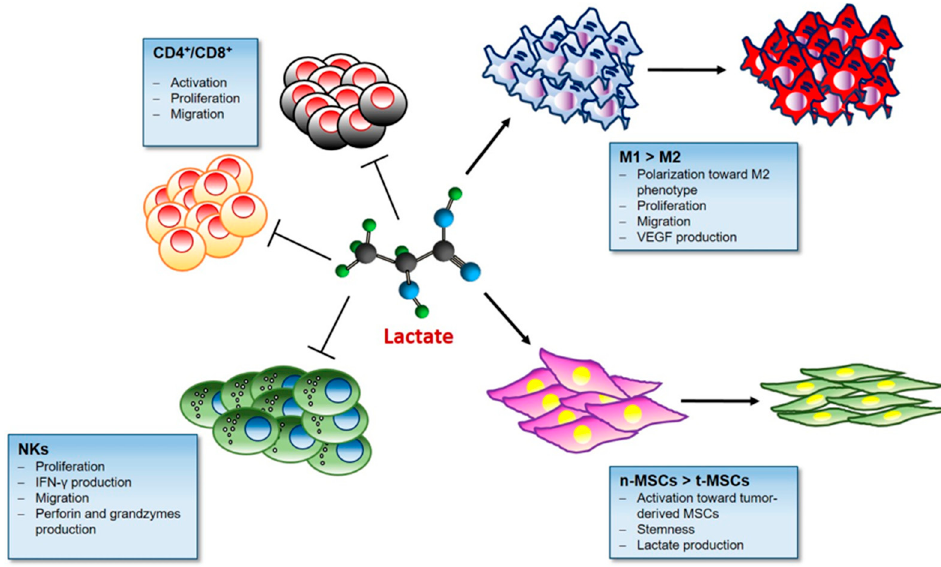
Figure 2. Lactate and the Immune response. Lactate in the tumor microenvironment impairs immune surveillance by blocking natural killer (NK) cells and tumor infiltrating T cells. Lactate-rich milieu promotes Treg cell survival and their immunosuppressive function. Moreover Lactate stimulates the M2 pro-tumoral polarization in macrophages and activates mesenchymal stem cells (MSCs).